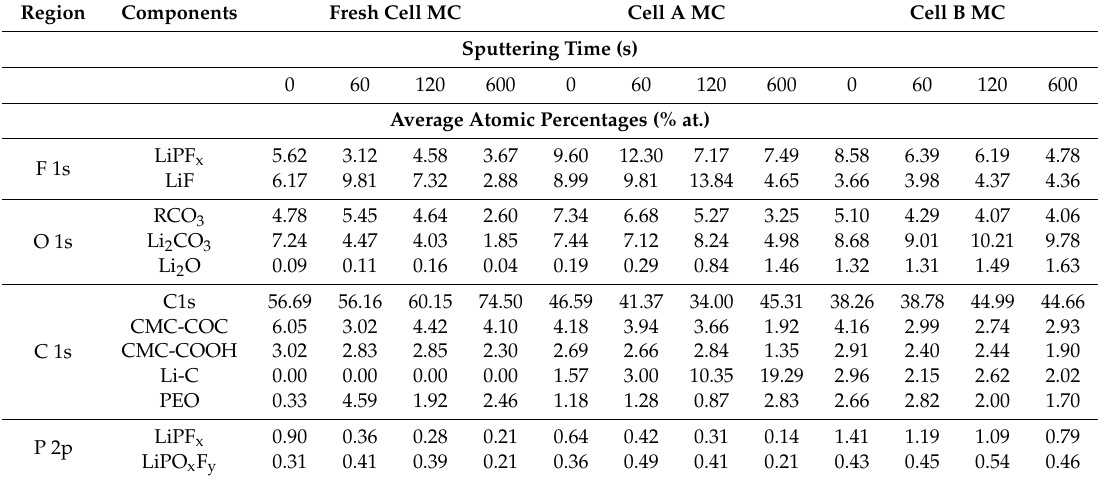
Table 6. Average atomic percentages (% at.) determined from three measurement spots on fresh and aged graphite electrodes.